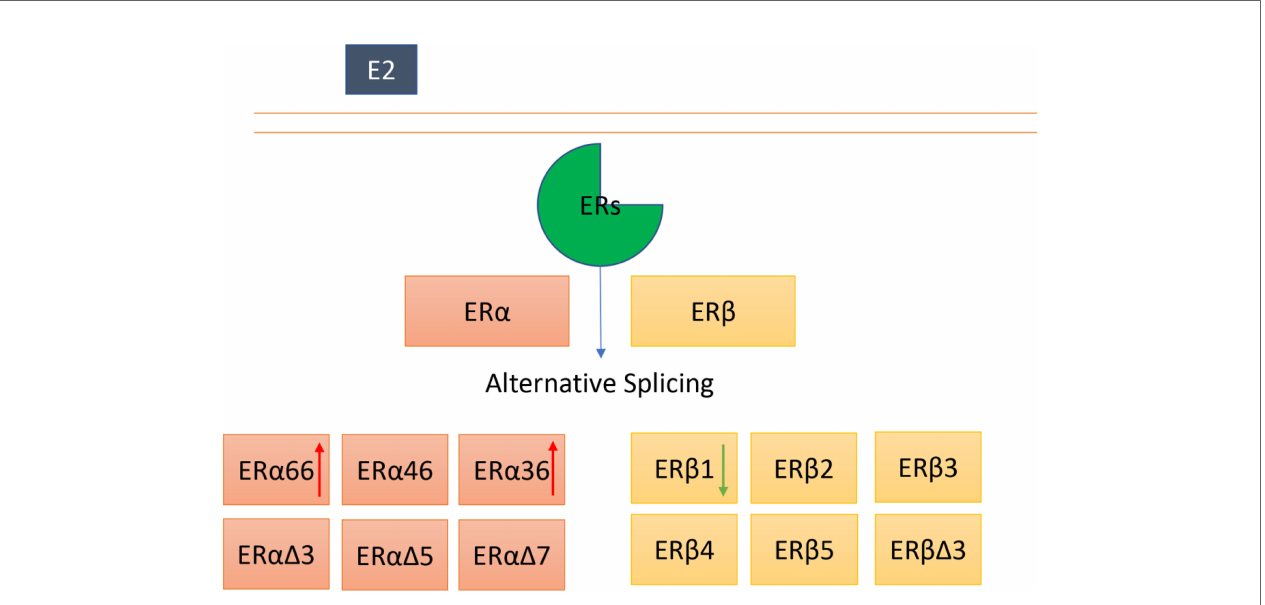
GRAPHICAL ABSTRACT | ER a and ER b can undergo alternative splicing, and several isoforms of ER a and Er b have been identi fi ed. The roles of ER a and ER b full length in thyroid cancer appear to be controversial. Moreover, the exact functions of other isoforms in thyroid cancer remain largely unknown. The red arrow indicates an increased expression, the green arrow represents a deceased expression in thyroid